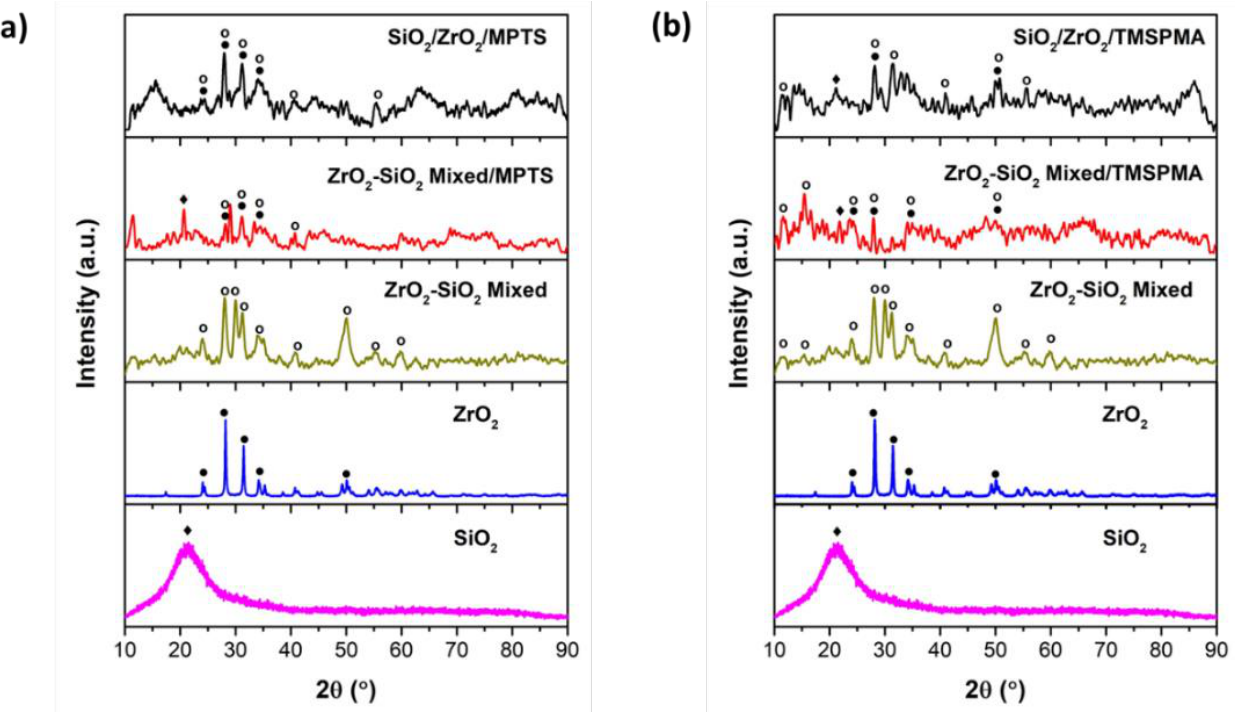
Figure 8. XRD composite post with silane addition: ( a ) MPTS and ( b ) TMSPMA. XRD spectra references are SiO 2 Tridymite/COD 96-900-7155 (solid square) and ZrO 2 Baddeleyite/COD 96-900-7486 (solid circle).